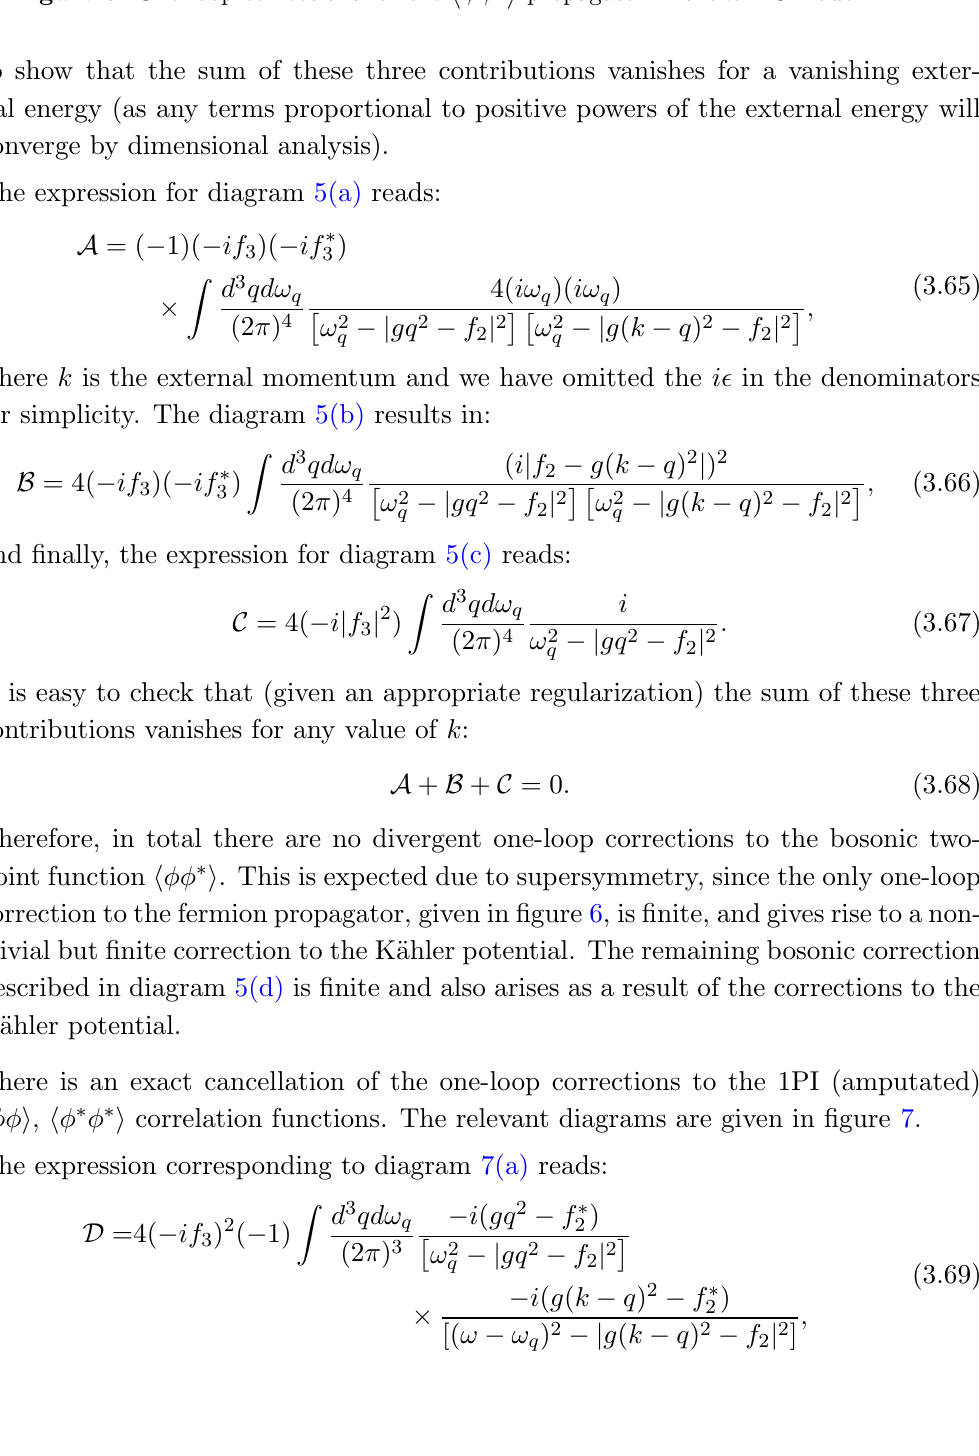
Figure 6 . One-loop corrections for the